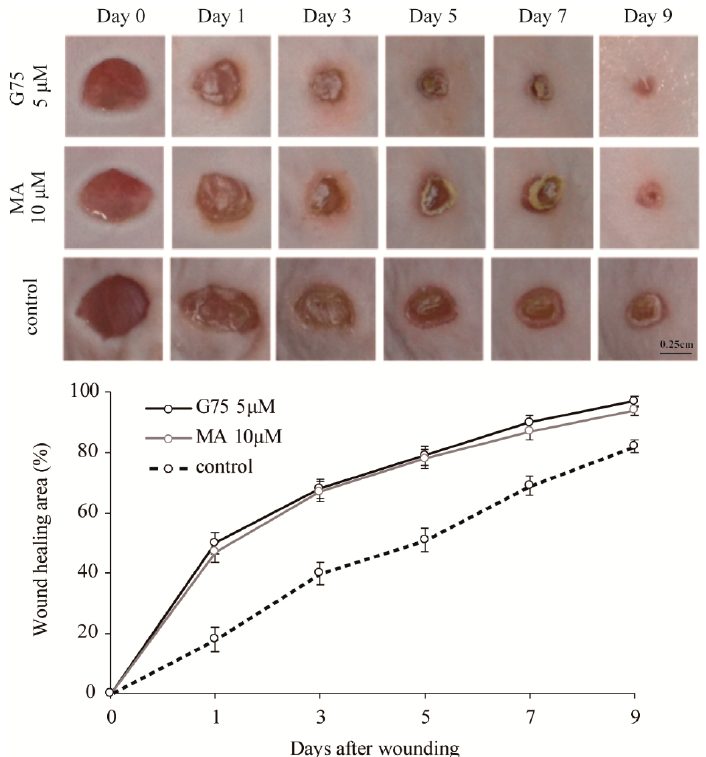
Figure 3. Effects of G75 on excision wound healing in mice. After the excision wound was made using a 5-mm diameter biopsy punch, either 5 µM of G75 or 10 µM of MA was applied to the wound surface. DMSO was used as vehicle control. The wound healing area was measured on indicating days from the day of wounding. The results are presented as means ± S.E.M ( n =